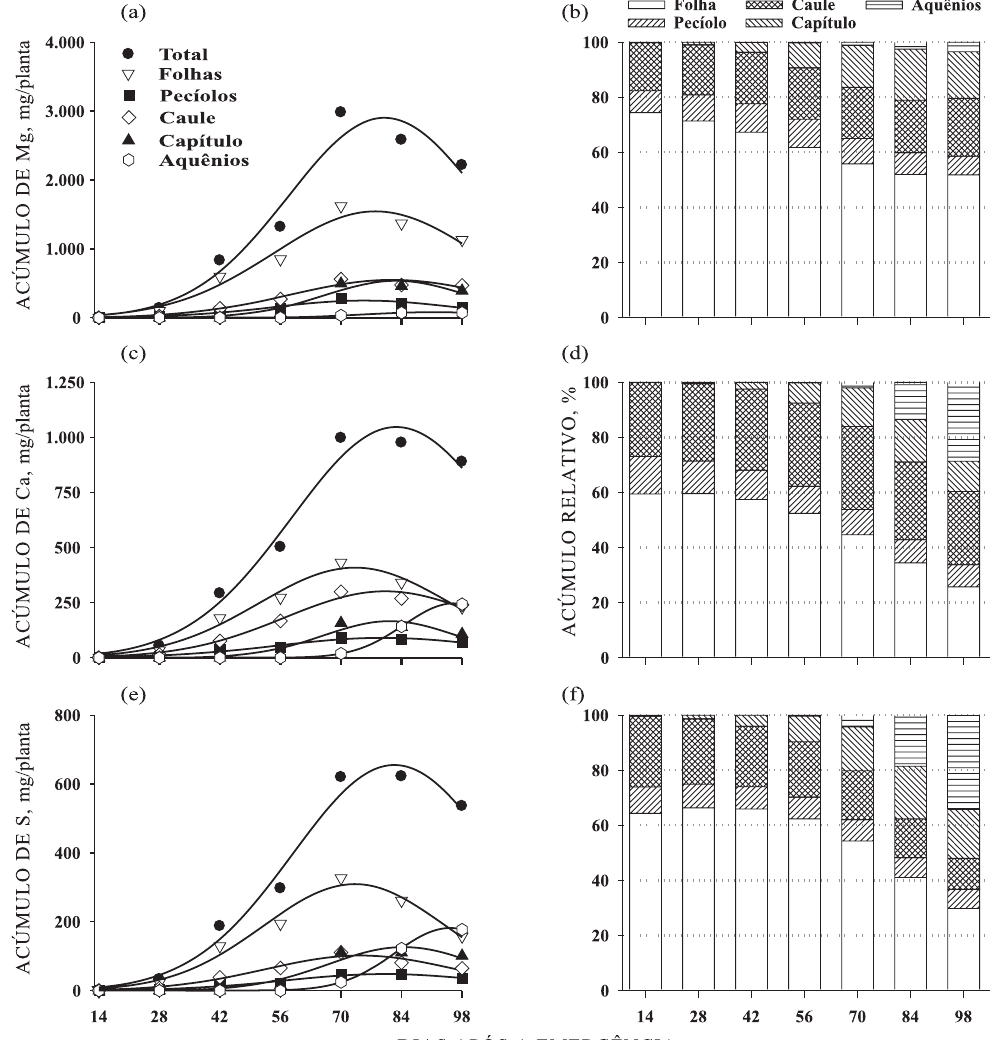
Figura 3. Marcha de absorção dos macronutrientes secundários e respectivo acúmulo relativo nas partes das plantas. (a) e (b): cálcio; (c) e (d): magnésio; (d) e (f):